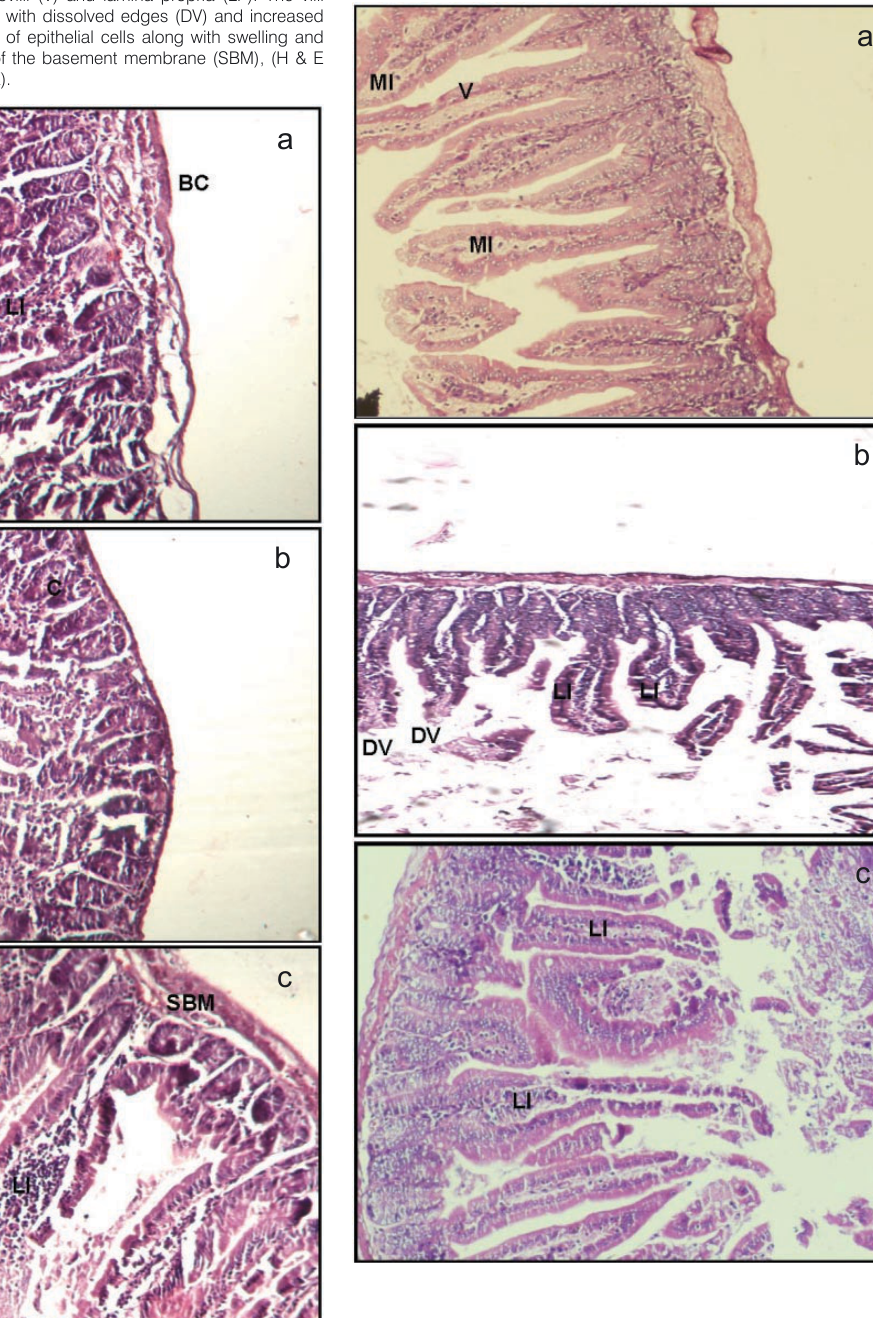
Figure 7. Photomicrograph of the small intestine of a Probiotic- Giardia mouse (Group IV); a) on day 7 PI showing a preserved architecture of microvilli (V) with mild inflammation (MI); b) on day 14 PI showing a large number of lymphocytes in the microvilli and in the lamina propria. Note the less-dissolved villi tips (DV); c) on day 21 PI showing mild cellular disruption of the mucosal epithelial lining and the large number of lymphocytes in the microvilli, (H & E stain, 100